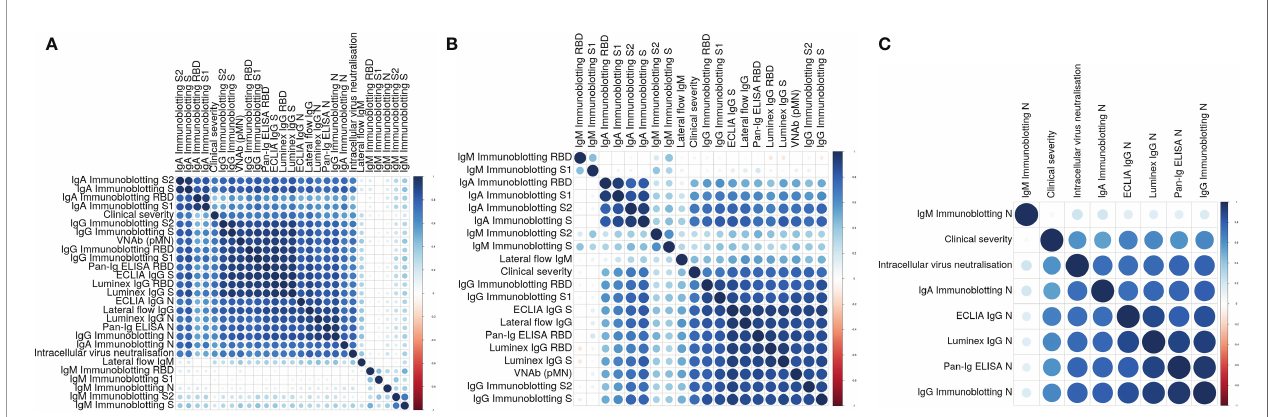
FIGURE 2 | (A) Correlation plot showing pairwise Spearman ’ s rank correlation between assays. Darker and larger points indicate stronger correlations. Blue indicates positive and red indicates negative correlations. Assays are ordered by hierarchical clustering so that assays with similar relationships are together. (B) Correlation plot showing pairwise Spearman ’ s rank correlation between clinical severity, pMN and S-speci fi c antibody assays. Darker and larger points indicate stronger correlations. Blue indicates positive and red indicates negative correlations. Assays are ordered by hierarchical clustering so that assays with similar relationships are together. (C) Correlation plot showing pairwise Spearman ’ s rank correlation between clinical severity, intracellular neutralization and N-speci fi c antibody assays. Darker and larger points indicate stronger correlations. Blue indicates positive and red indicates negative correlations. Assays are ordered by hierarchical clustering so that assays with similar relationships are